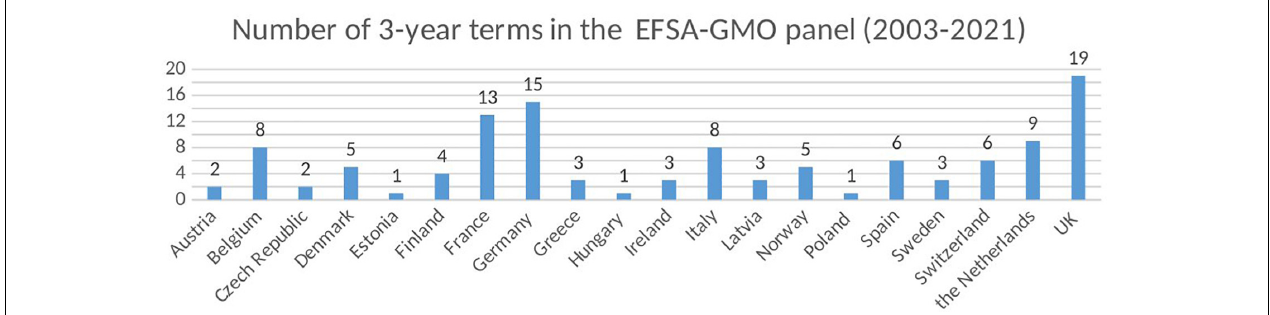
FIGURE 3 | Composition of the EFSA-GMO panels by the EU member states from 2003 to 2021.